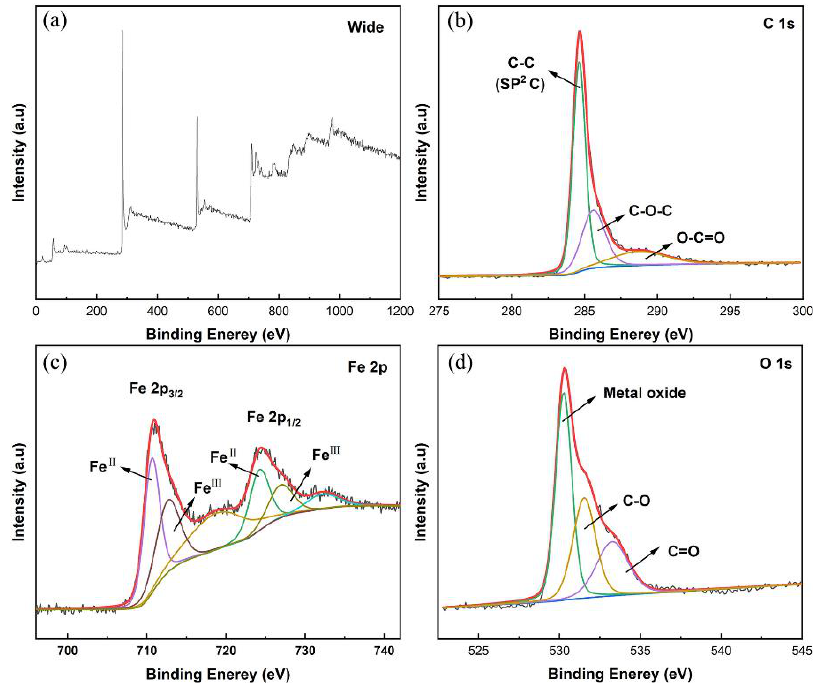
Figure 3. XPS spectra of ( a ) wide, ( b ) C 1s, ( c ) Fe 2p, and ( d ) O 1s of n-Fe 3 O 4 /ACF .